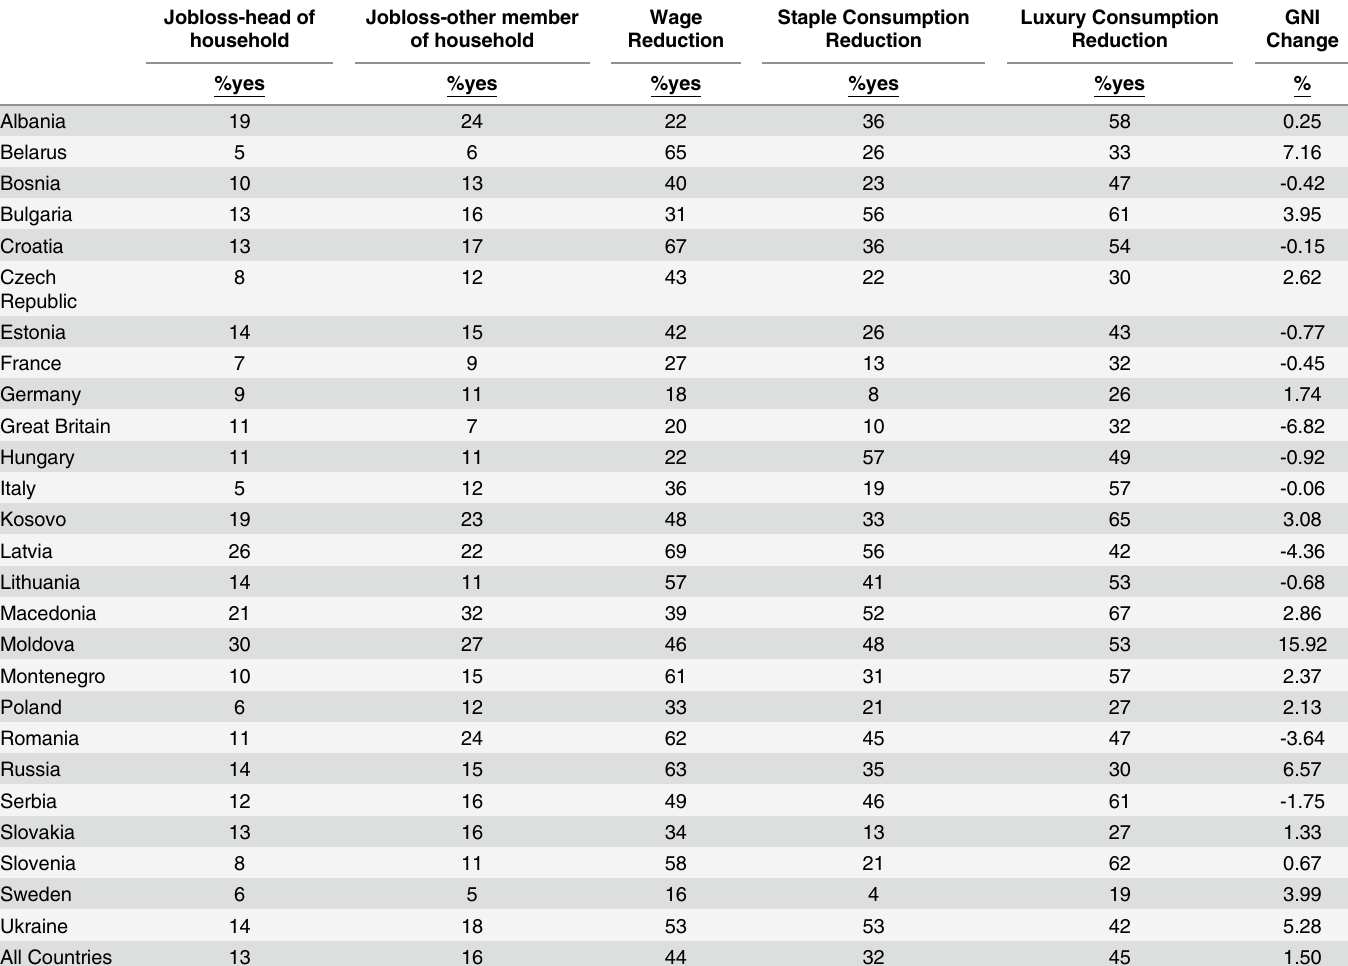
Table 3. Recession Experience by